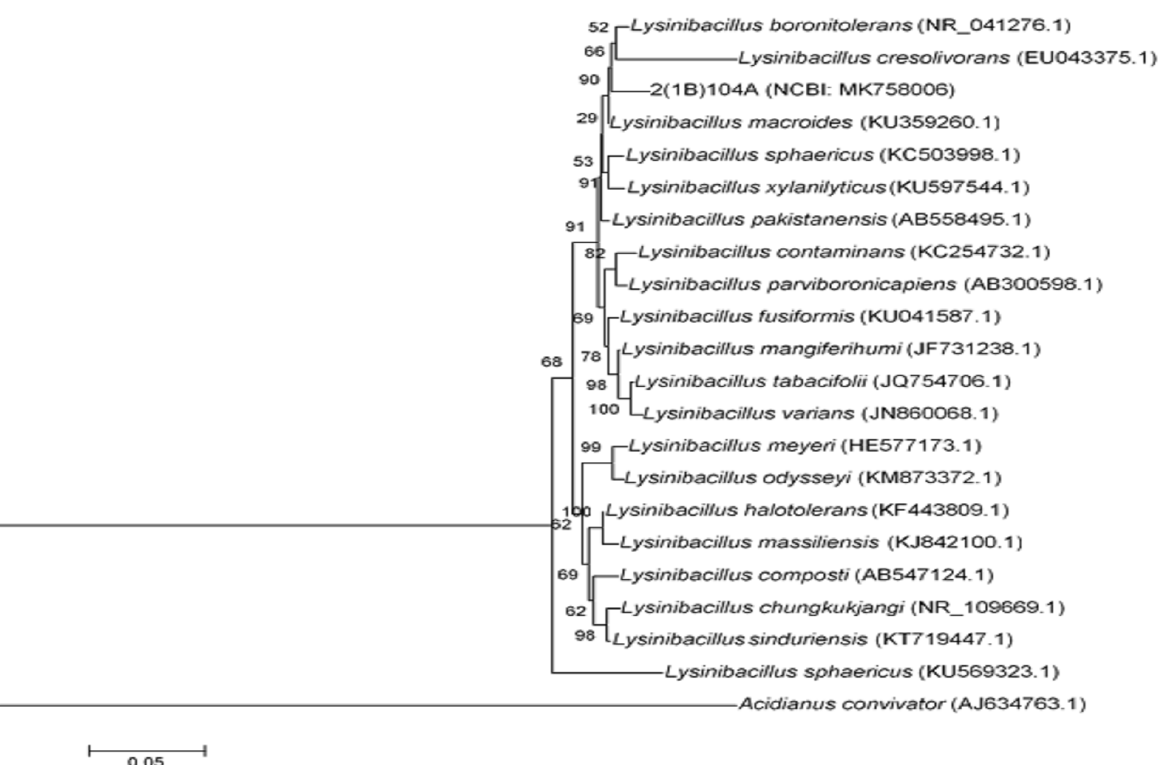
Figure 5. Phylogenetic tree of the strain 2(1B)104A with respect to the species of Lysinibacillus conducted with the Neighbor Joining method, the accession number registered on the NCBI for the species utilized in the analysis is shown in